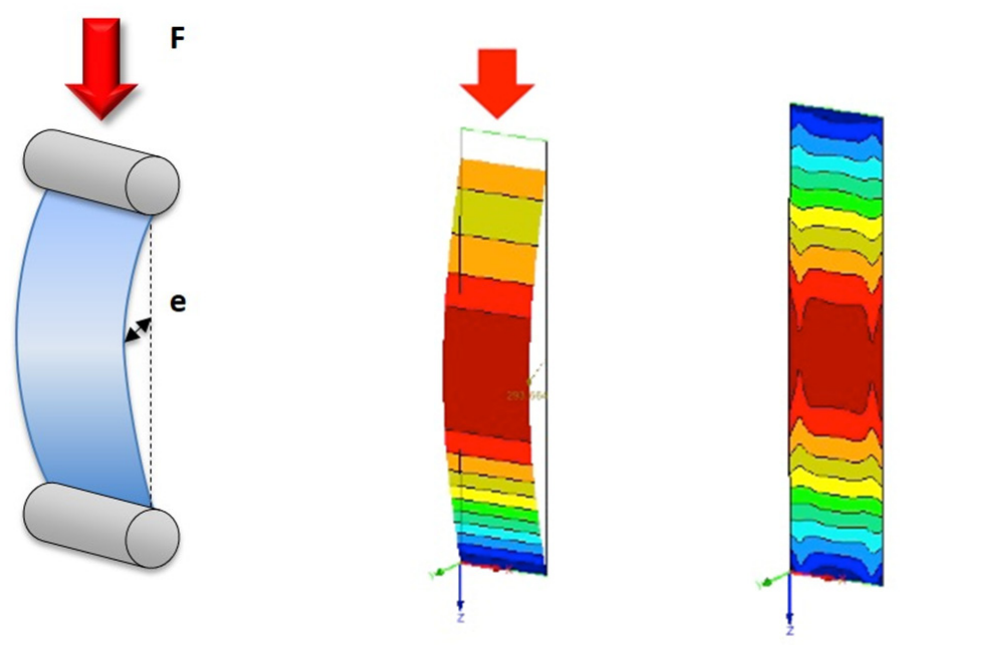
Fig. 8 Principle test set-up for bending in-plane force, defection and stress